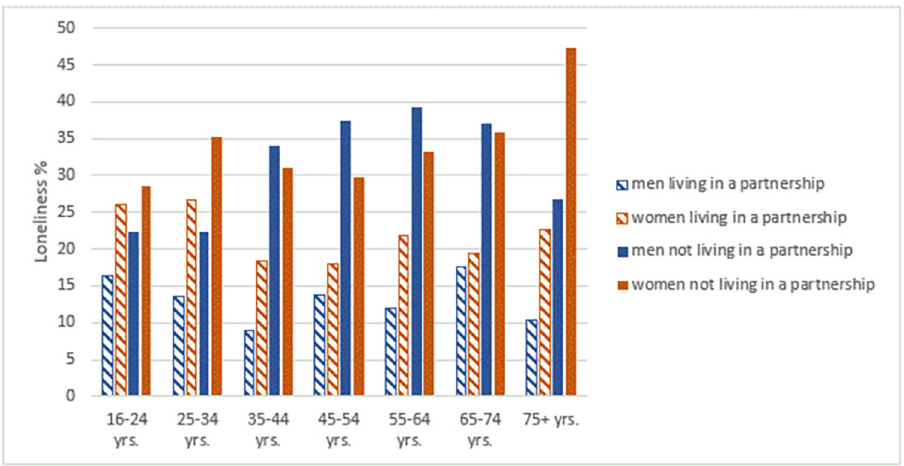
Fig 1. Loneliness across age groups based on a single-item screening measure, stratified by sex and living in a partnership. Reported prevalence rates of loneliness based on the binary coding of the single-item measure of